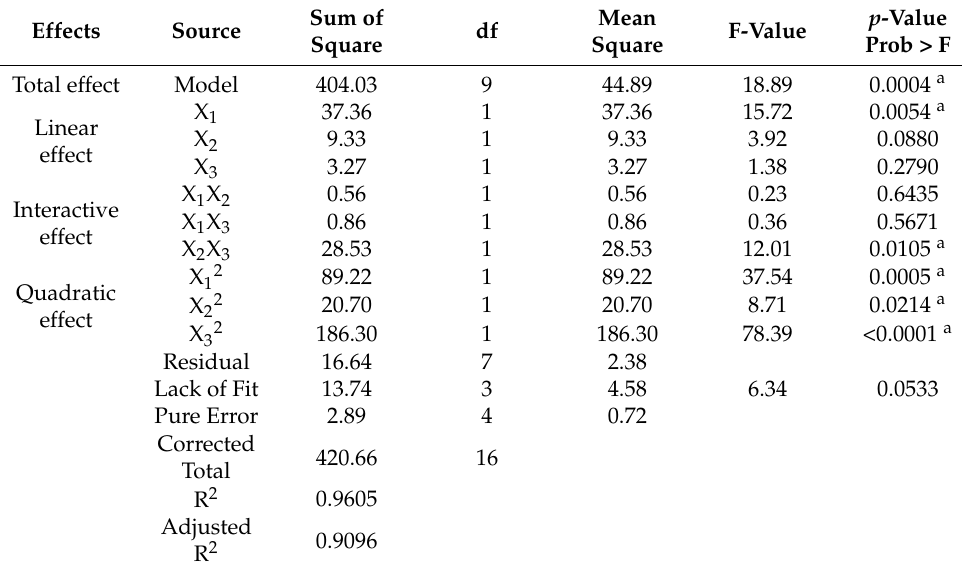
Table 3. ANOVA for the response surface quadratic